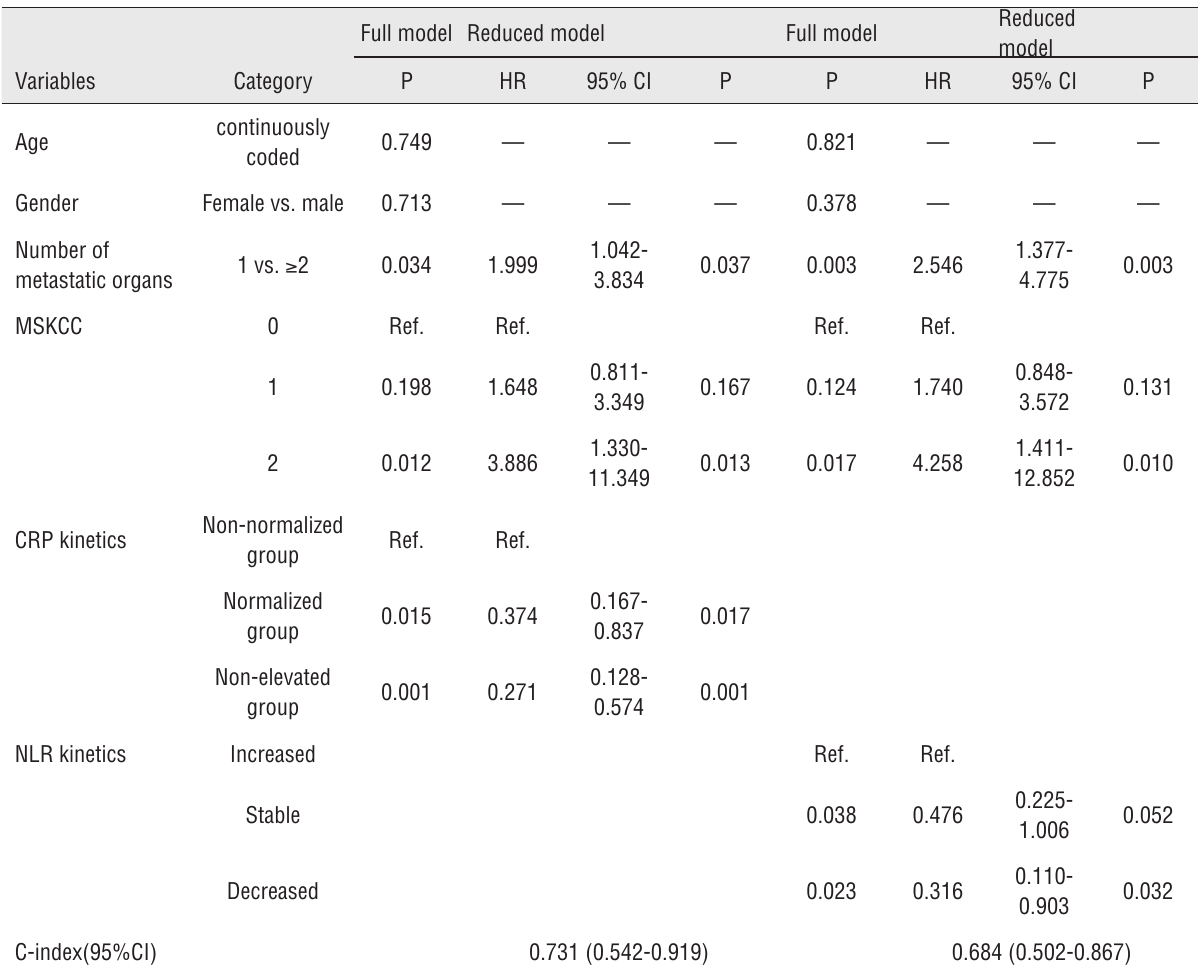
Table 3 - Multivariate Analysis for Overall